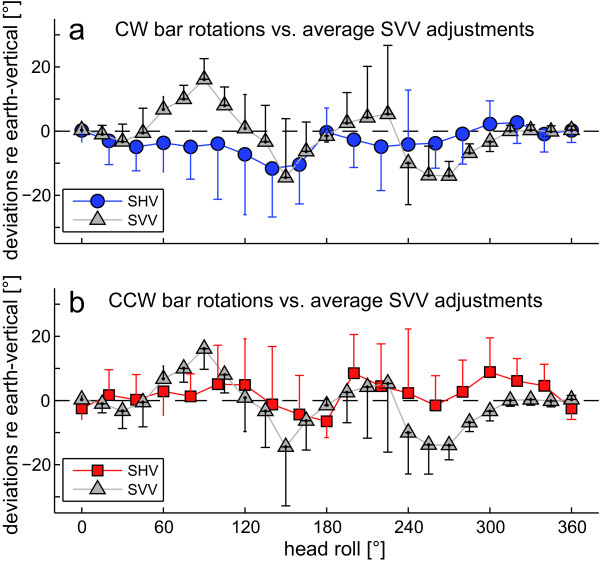
Average (± 1 StdDev) deviations of SHV (blue and red circles) and SVV (gray triangles, from [8]) in all subjects relative as a function of head roll. Note that trials with CW and CCW rotations of the SVV condition are pooled as no main effect for the direction of arrow rotation was previously noted [8]. Trials with CW rod rotations (blue circles) were shifted CCW relative to trials with CCW rod rotations (red squares) in most head-roll positions. Both for trials with CW rod rotations (upper panel) and for trials with CCW rod rotations (lower panel) the modulation of adjustments within the roll plane is clearly different from average SVV adjustments, showing deviations of smaller size and little roll-angle dependency.